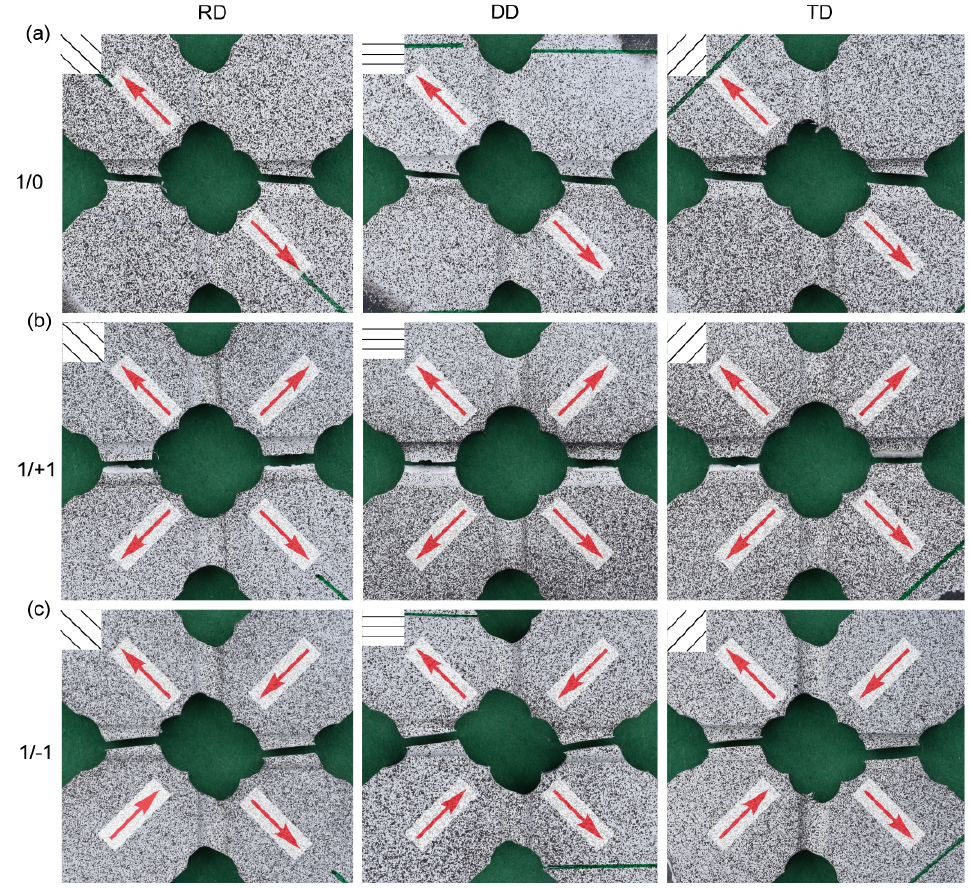
Figure 10. Fractured specimens for the load ratios ( a ) F 1 / F 2 = 1/0, ( b ) F 1 / F 2 = 1/+1 and ( c ) F 1 / F 2 = 1/ −